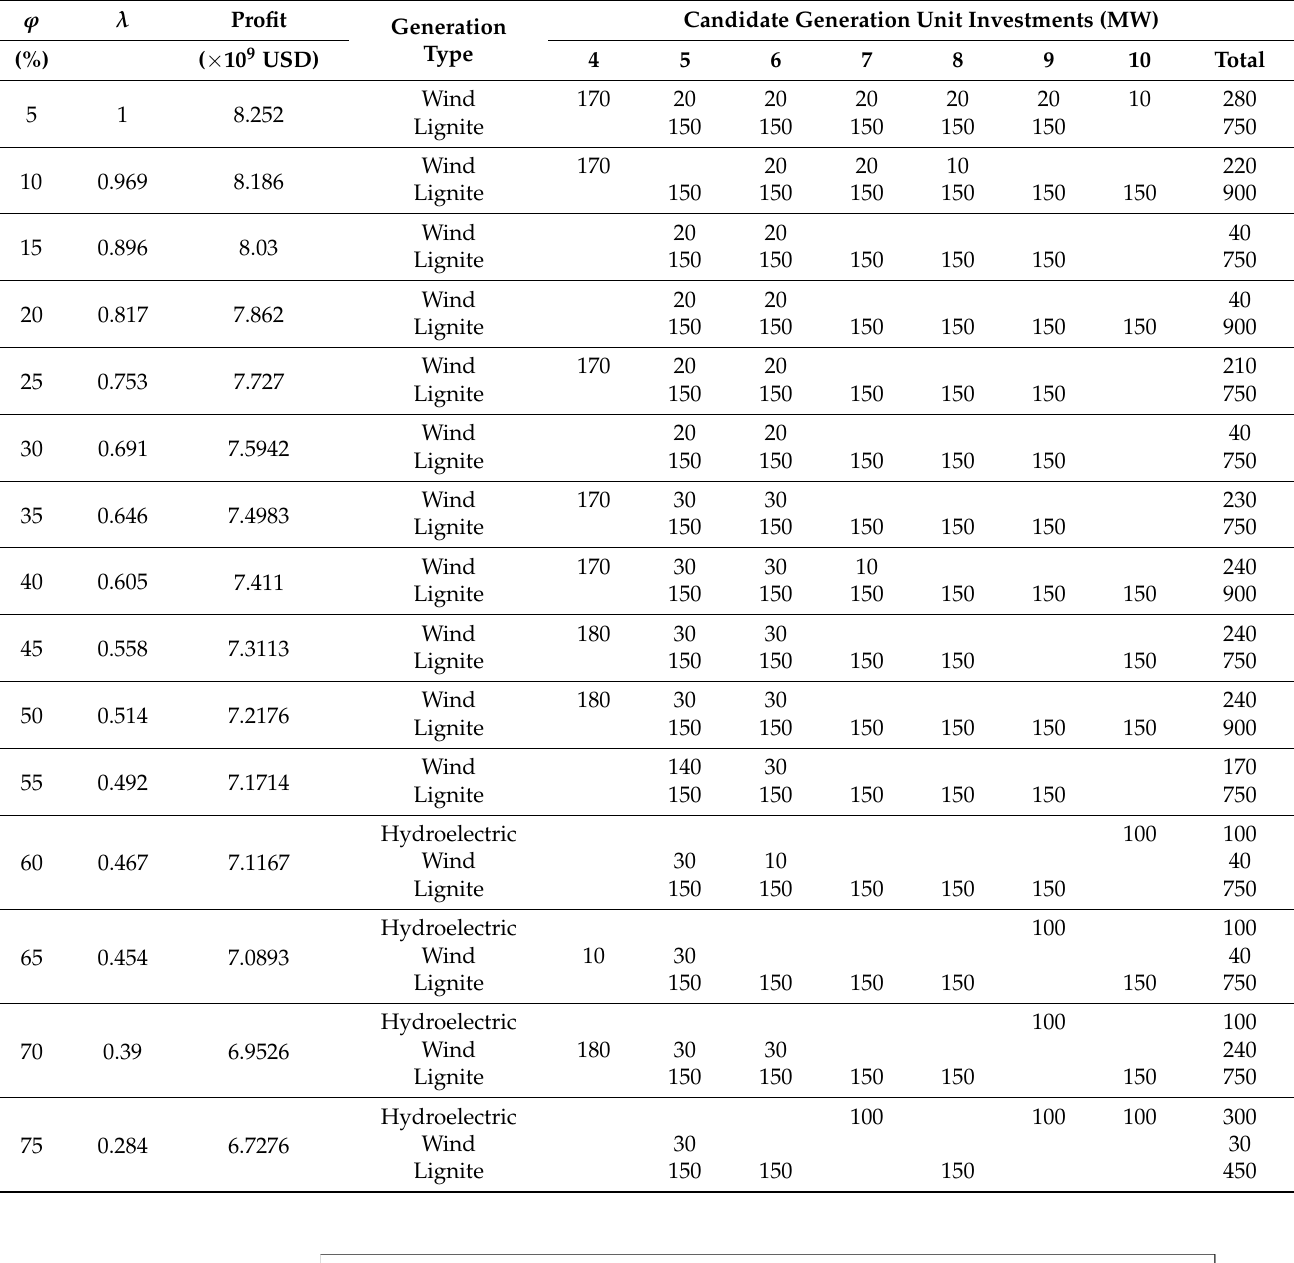
Table 7. The relationship between ϕ , λ , and the change in the investment plans.